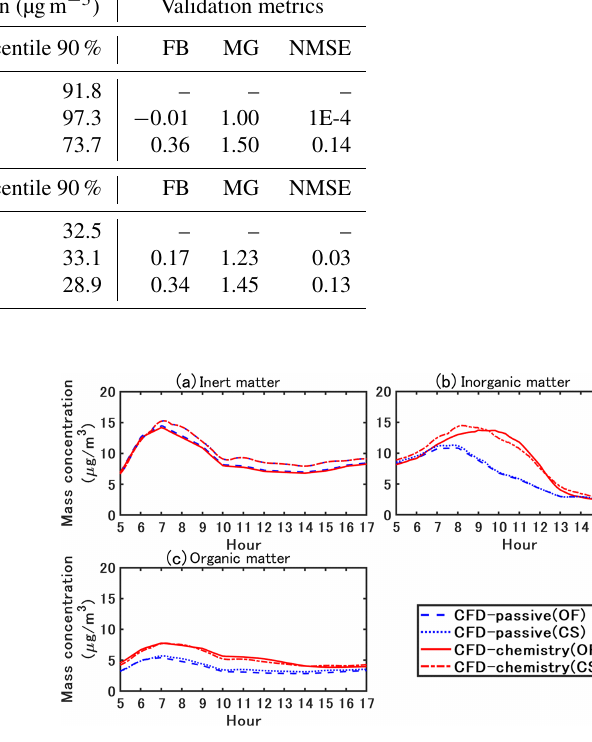
Figure 5. Measured and simulated black carbon concentrations with OpenFOAM. The canyon-averaged and maximum concentra- tions in the street canyon are represented by the plain line and the dashed line, respectively (27 . 5 ≤ x ≤ 55 , 0 ≤ z ≤ 8 . 5 m).